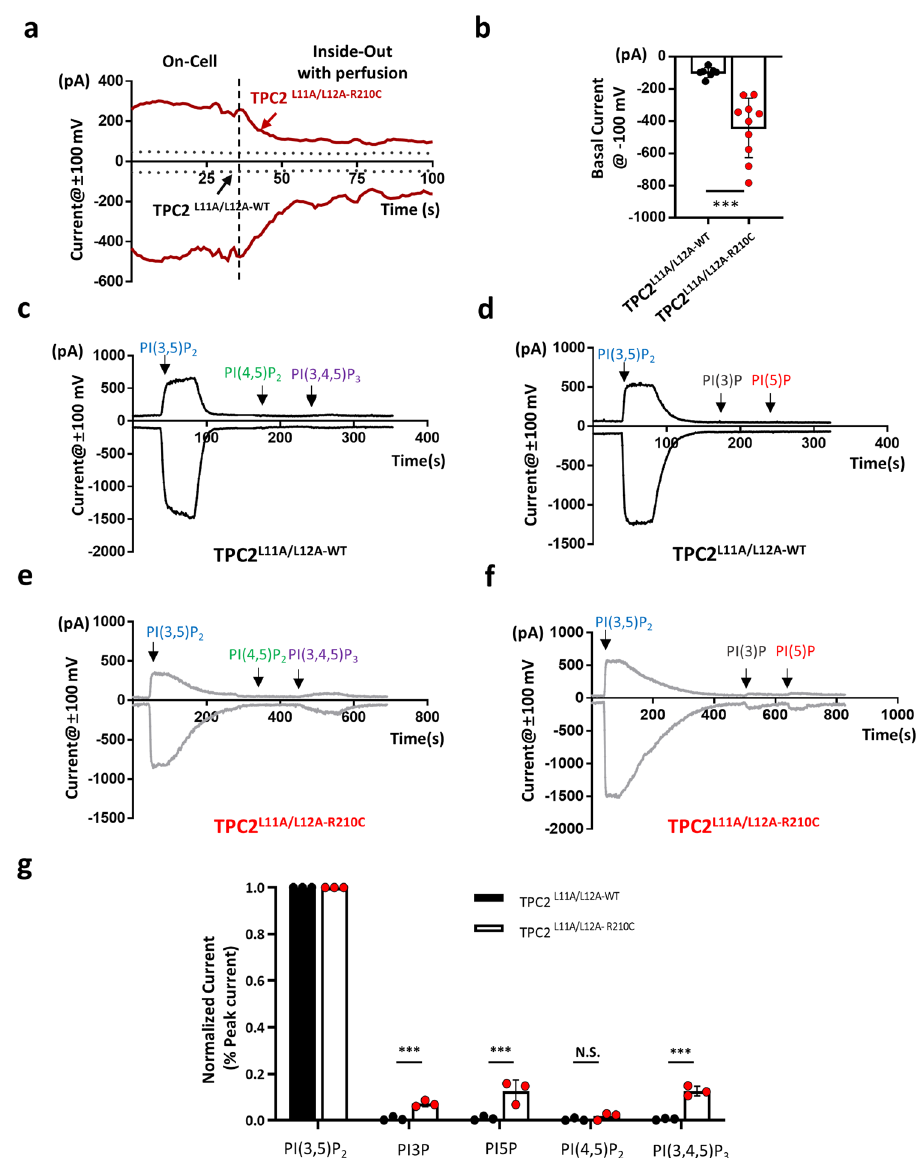
Fig. 4 | TPC2 L11A/L12A-R210C is constitutively active on the PM and activatable by additional phosphoinositide species. a Representative traces of TPC2 L11A/L12A-WT (gray dotted lines) and TPC2 L11A/L12A-R210C currents (red solid lines) at ±100mV recorded in on-cell patches followed by inside-out patches. Recordings were initi- ated during the on-cell period and continued during and after patch excision (vertical dashed line). Note the gradual decay of the TPC2 L11A/L12A-R210C currents after patch excision, the time from which the cytoplasmic side of the inside-out patch was continuously perfused with the bath solution. See Fig. 2a for patch clamp con fi guration and solutions. b Analysis of the basal current at − 100mV (WT: − 91.9±4.9pA, n =7; R210C: − 478.8±54.5pA, n =10). Data are presented in mean±SEM, *** p <0.001 by Student ’ s unpaired t -test, two-tailed. Source data are provided as a Source Data fi le. c , d Representative traces of TPC2 L11A/L12A-WT currents